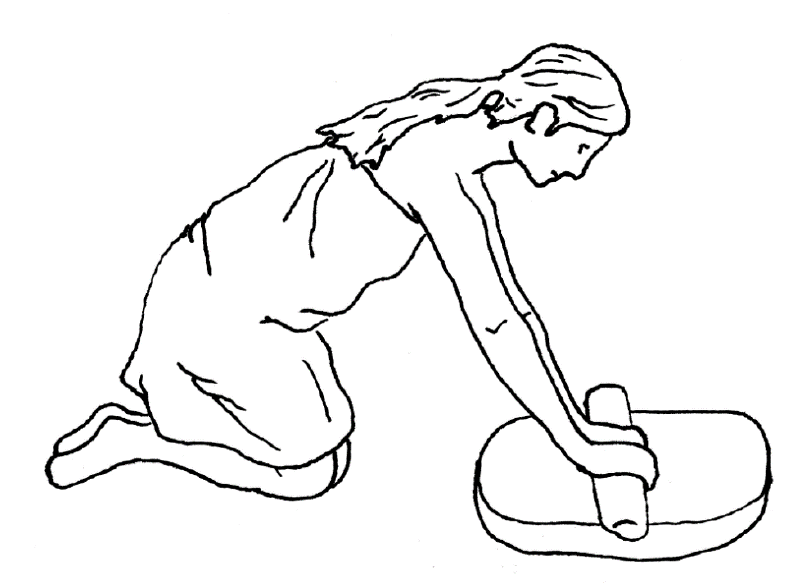
Figure 1: Woman grinding with quern on the floor. Drawing courtesy of J. Sylvia.